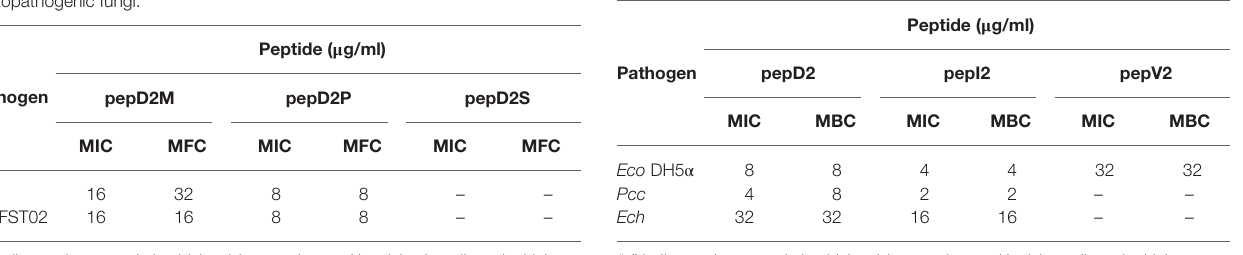
TABLE 7 | Antimicrobial activity of the peptides with different hydrophobic